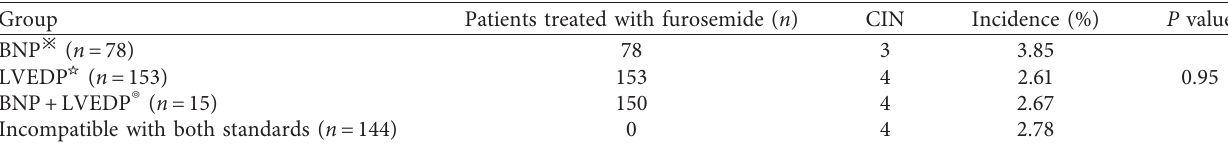
Table 3: Incidence of CIN in different subgroups within the experimental